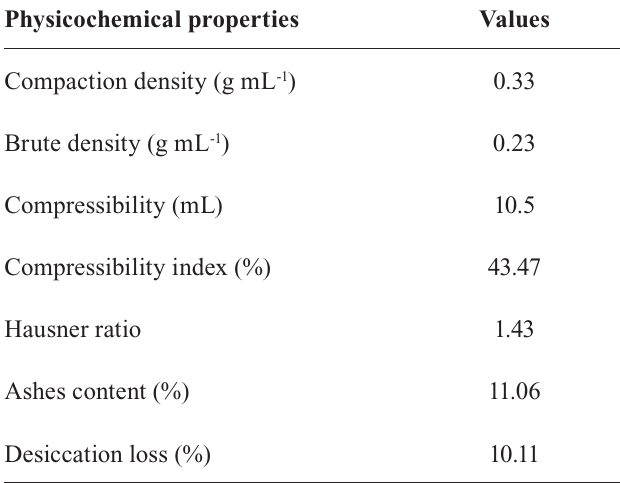
TABLE I - P hysicochemical properties of the vegetal drug from